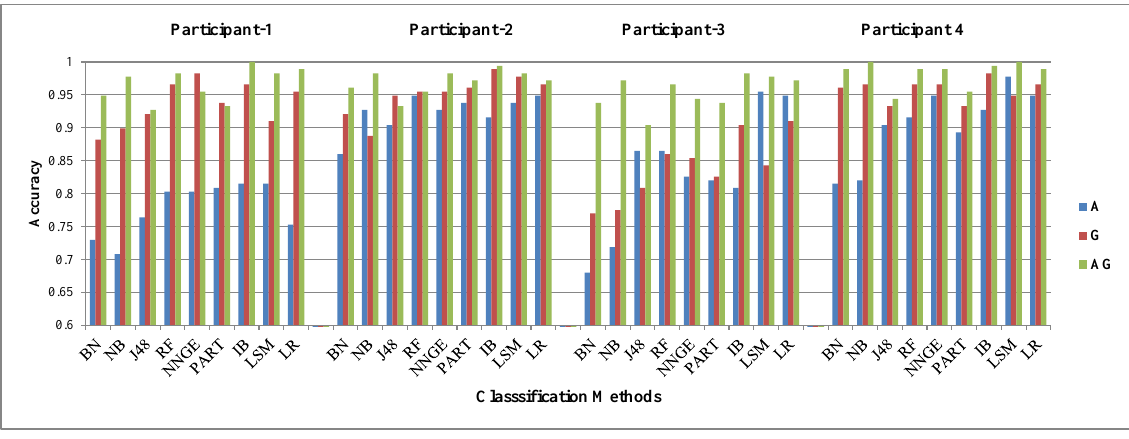
Figure A.8. Recognition performance for the walking downstairs activity in Scenario C.